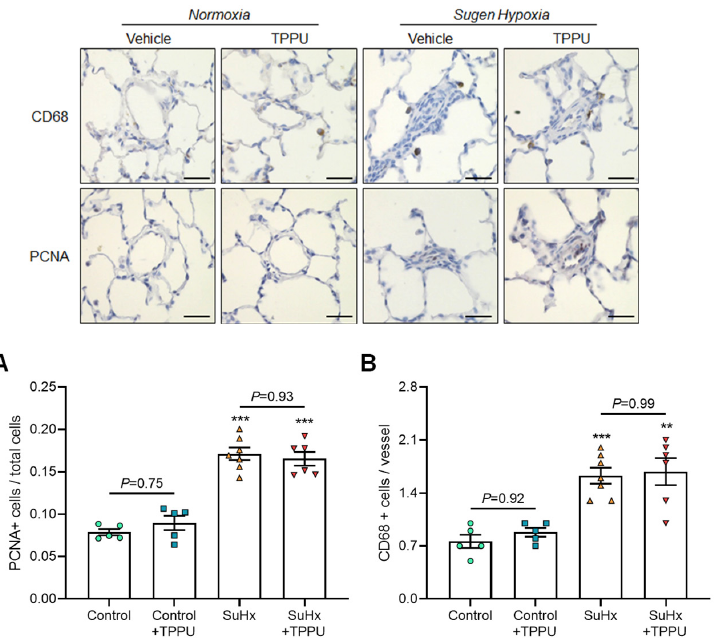
Figure 3. Representative images of proliferating cell nuclear antigen (PCNA) and CD68-stained sections of distal pulmonary arteries and quantification of the number of PCNA ( A ) and CD68 ( B ) positive cells per vessel obtained in normoxic control rats and in rats receiving Sugen 5416 associated with 3-week hypoxia (SuHx) treated with vehicle or with the soluble epoxide hydrolase inhibitor TPPU. Data were obtained in a subset of animals from each group. Scale bar: 20 µ m. ** p < 0.01, *** p < 0.001 vs. corresponding control